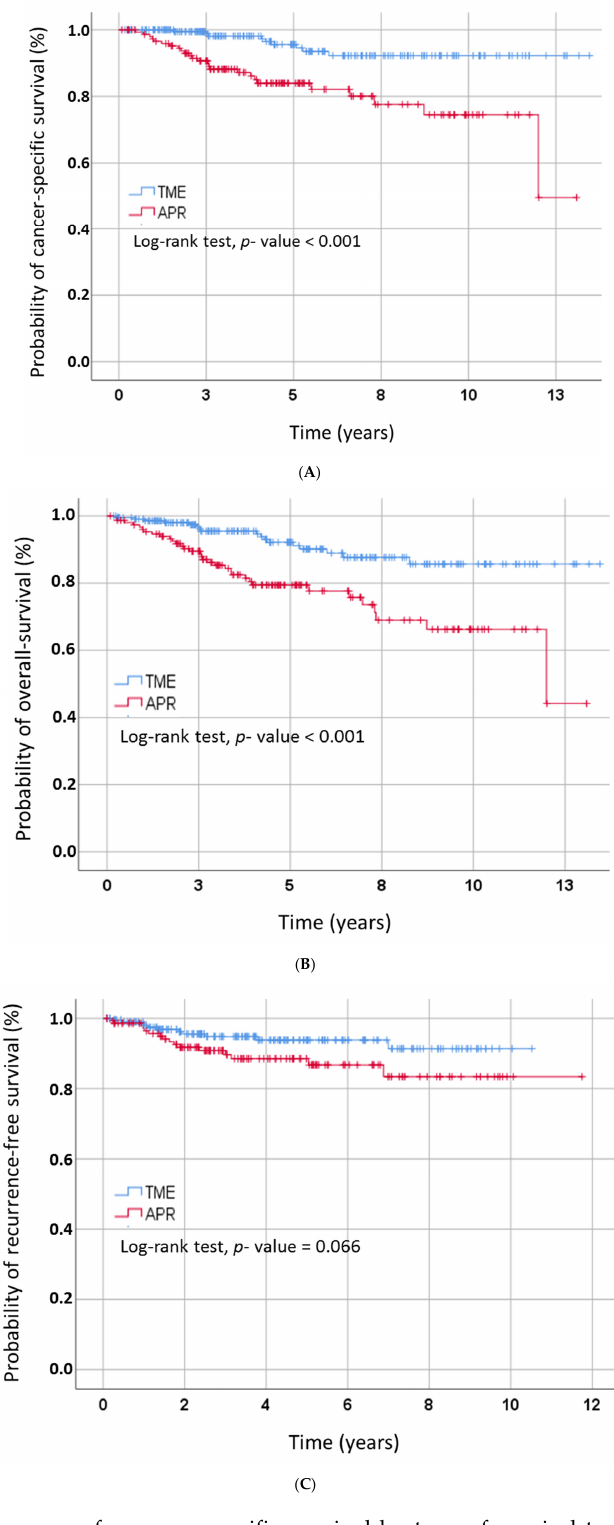
Figure 1. ( A ) Kaplan–Meier curves for cancer-specific survival by type of surgical treatment. Abbreviations: APR, abdominoperineal rectum resection; TME, total mesorectal excision; ( B ) Kaplan–Meier curves for overall survival by type of surgical treatment. Abbreviations: APR, abdominoperineal rectum resection; TME, total mesorectal excision; ( C ) Kaplan–Meier curves for recurrence-free survival by type of surgical treatment. Abbreviations: APR, abdominoperineal rectum resection; TME, total mesorectal excision.